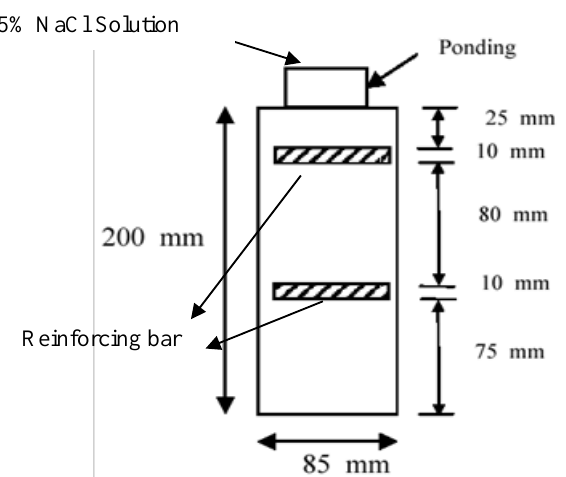
Fig. 2. Schematic of ponding test setup for reinforced concrete specimens